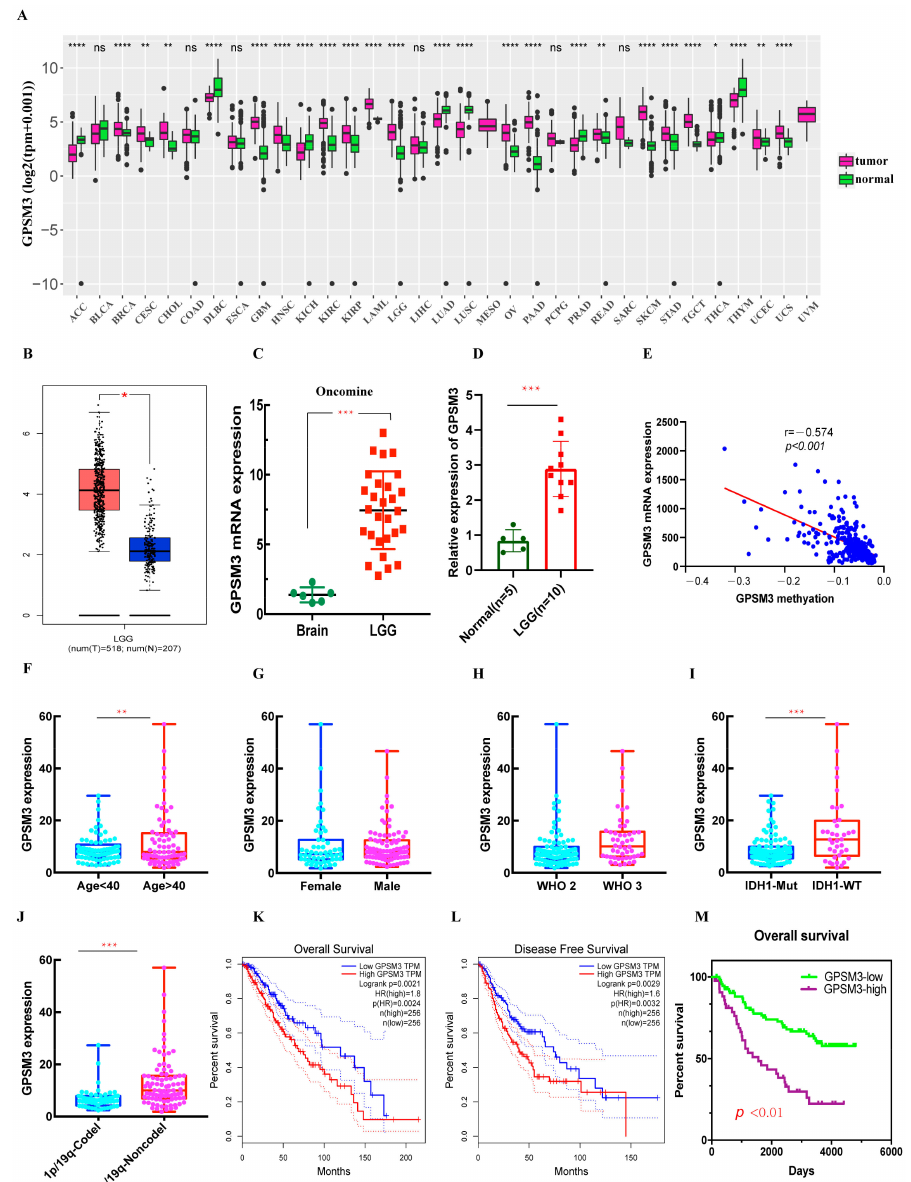
Figure 1. The mRNA Expression of GPSM3 in LGG and survival analysis. ( A ) The pan-cancer analyzed of GPSM3 mRNA expression, UCSCXenaShiny was used to visualize GPSM3 mRNA expression in the cancer genome atlas (TCGA) pan-cancer datasets. ( B ) The mRNA expression of GPSM3 in GEPIA website (Red color represent tumor tissues, Blue color represent normal tissues). ( C ) The mRNA expression of GPSM3 in dataset from ONCOMINE. ( D ) The mRNA expression of GPSM3 in LGG and normal brain tissues by PCR. ( E ) The expression of GPSM3 was negatively regulated by GPSM3 DNA methylation. ( F – J ) Correlation between GPSM3 mRNA expression and clinical indexes of LGG patients from CGGA database. ARL9 mRNA expression is stratified by age, gender, WHO grade, IDH1 mutation and 1p19q codeletion. * p < 0.05; ** p < 0.01; *** p < 0.001; **** p < 0.0001, ns = no significance. ( K , L ) Kaplan-Meier curves of low and high GPSM3 expression in LGG patients from TCGA dataset (Red color represent high GPSM3-LGG patients, Blue color represent low GPSM3-LGG patients). ( M ) Kaplan-Meier curves of low and high GPSM3 in LGG patients from CGGA